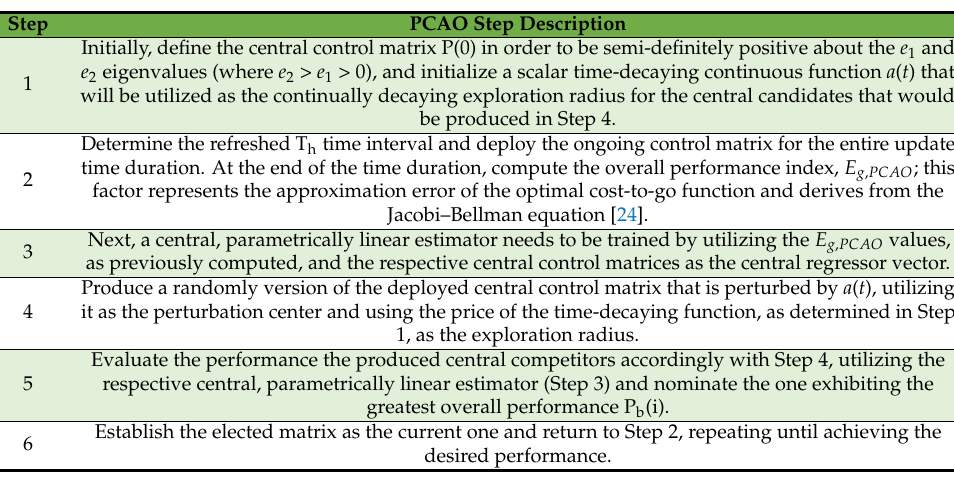
Table 2. Implementation of PCAO